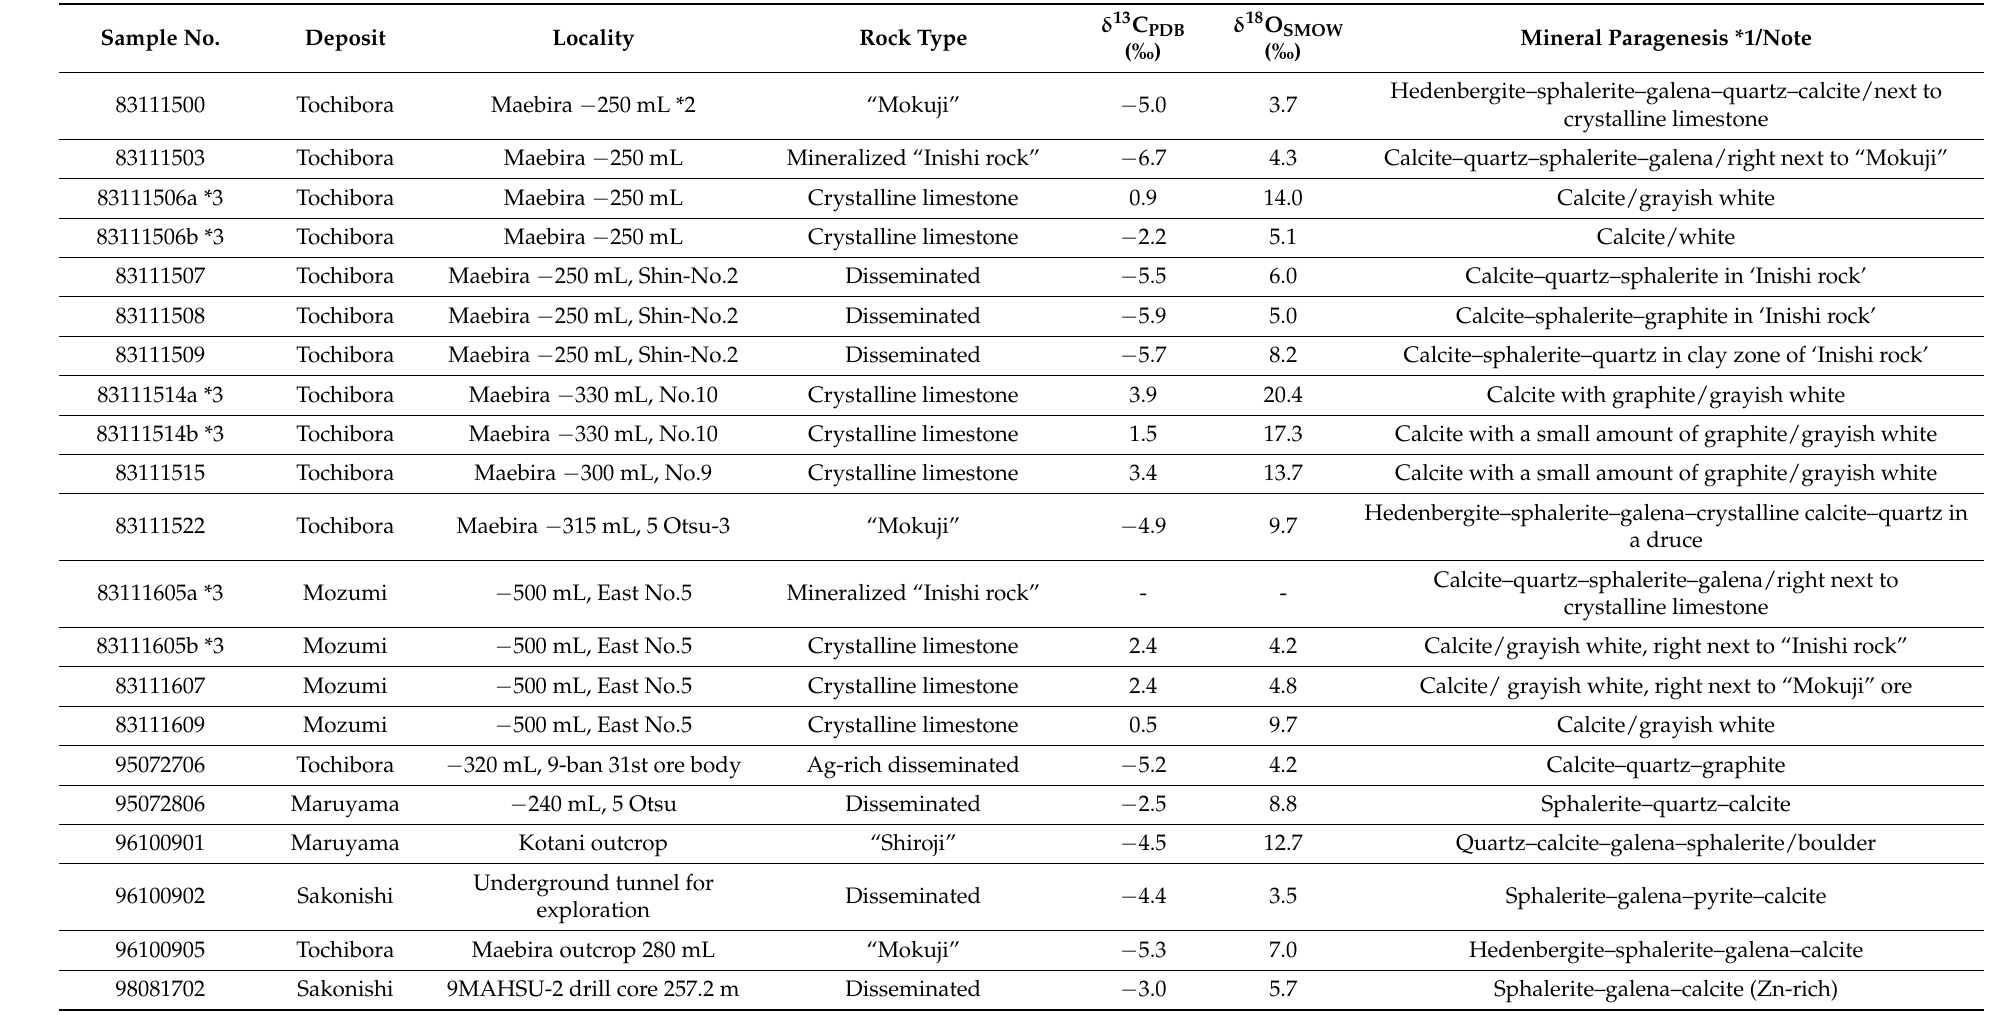
Table 1. Descriptions and isotope data of various rocks from the Kamioka mining